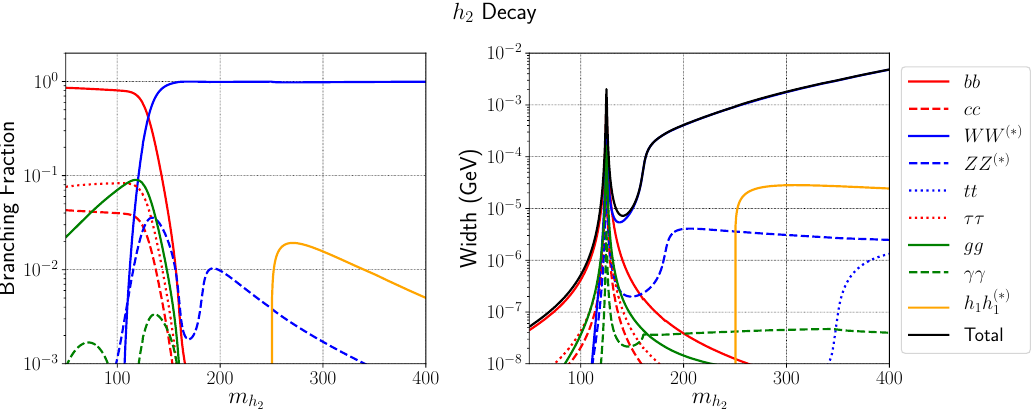
2 , for 125 GeV occurs due to an increase 2 (cid:25)